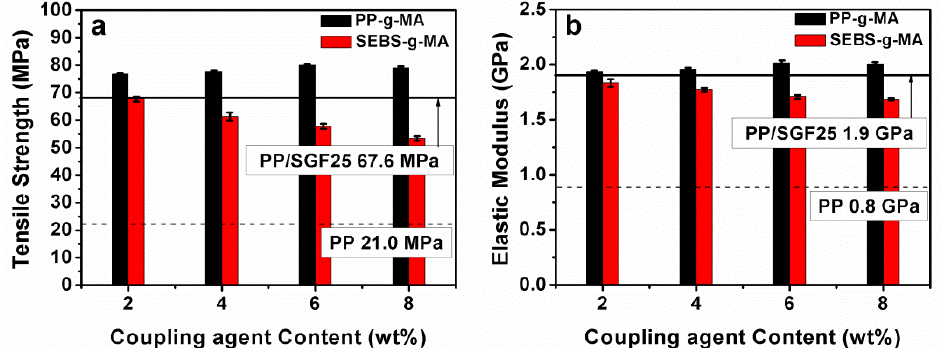
Figure 1. ( a ) Tensile strength and ( b ) tensile modulus of PP (Polypropylene)/SGF (short glass fiber) composites. Table 2. Mechanical properties of pure PP matrices and PP/SGF composites treated with various amounts of coupling agents.